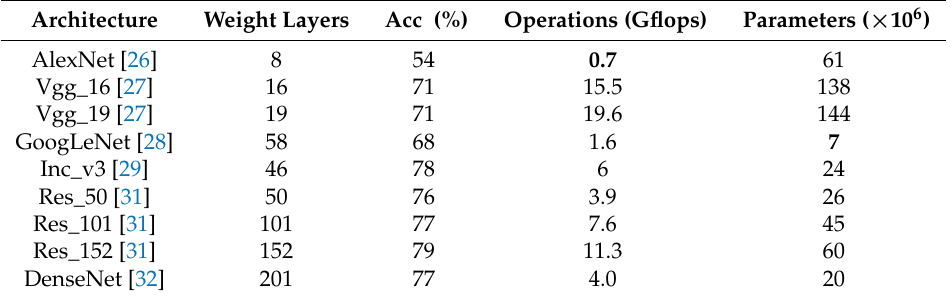
Table 1. Attributes of different CNN architectures exploited in the area of object